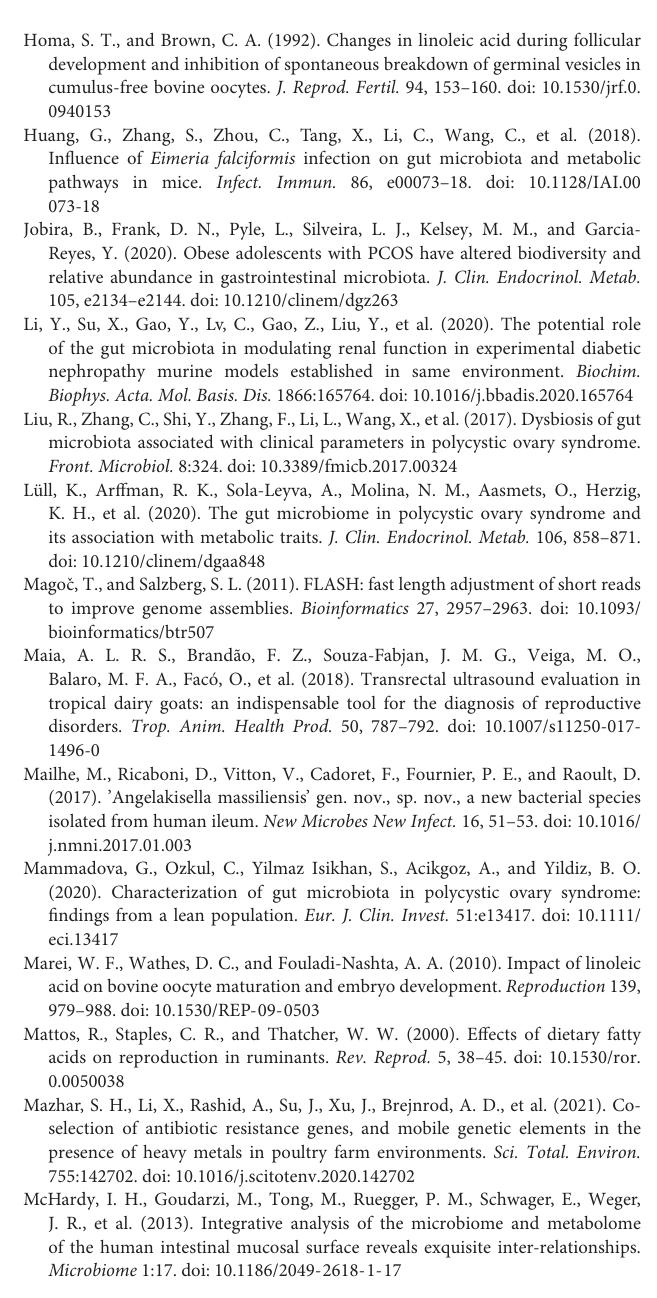
Supplementary Figure 1 | The linear discriminant analysis (LDA) effect size (LEfSe) algorithm of significant differences between fecal bacterial taxa in follicular cyst ewes and normal follicle ewes from family to genus